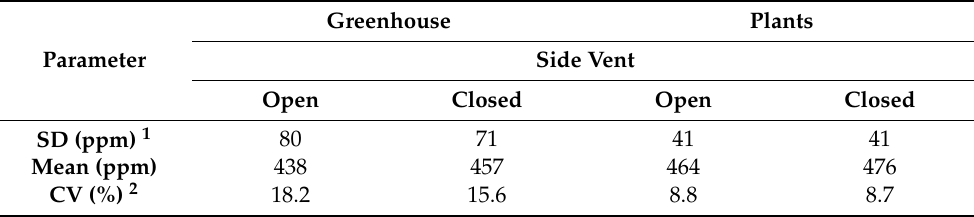
Table 5. Coefficient of variations of CO 2 concentration in the case of side vents open and closed.